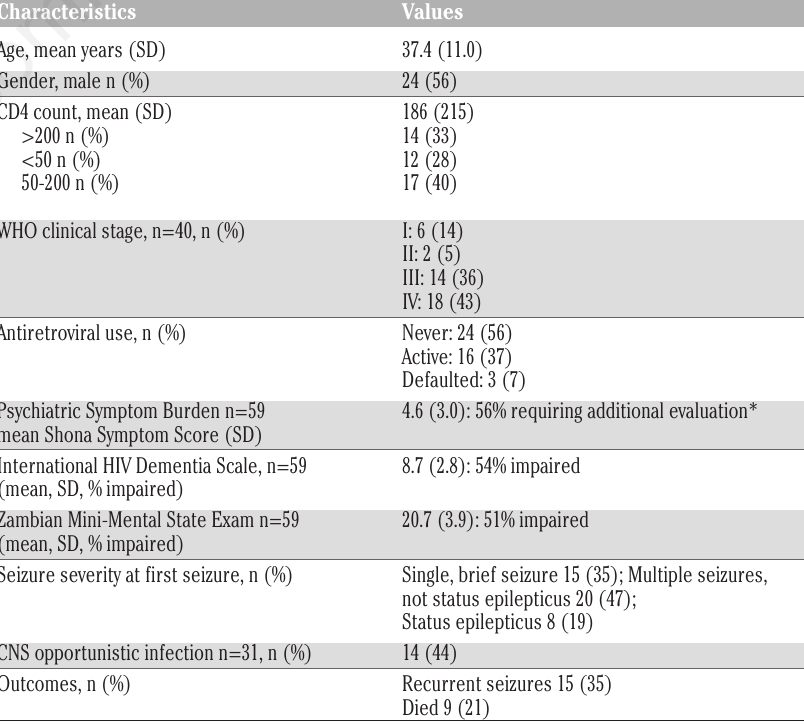
Table 1. Clinical characteristics and outcomes